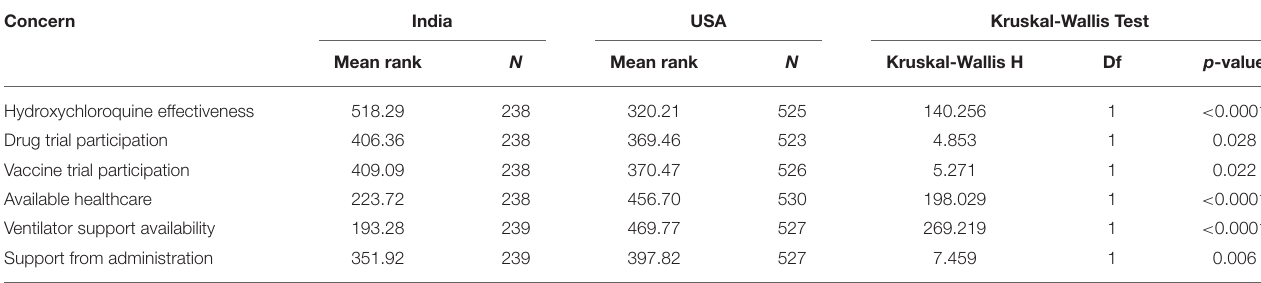
TABLE 3 | Comparative analyses of perception scores about the local healthcare facilities, hydroxychloroquine effectiveness, and other preventive behaviors between Indian and US-based participants (US-P) during COVID-19.